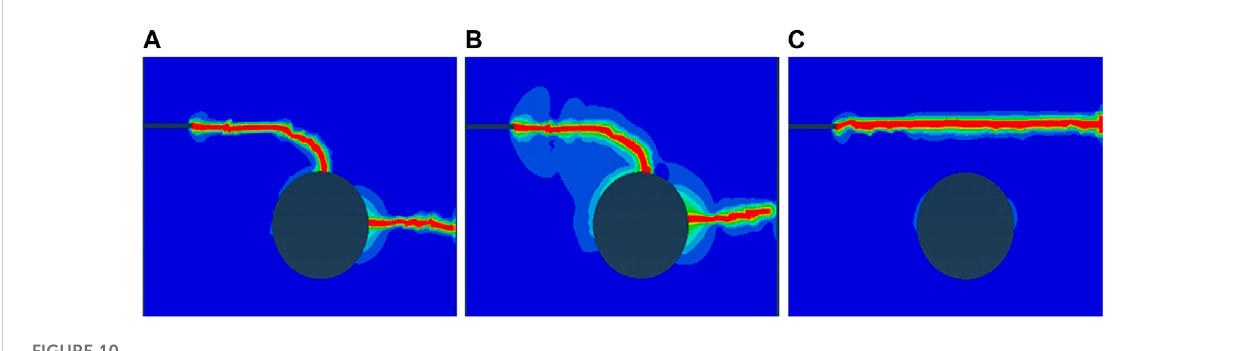
FIGURE 10 (A) CrackpropagationpathS=1.107(elementsize0.4). (B) CrackpropagationpathS=1.107(elementsize0.4). (C) CrackpropagationpathS=1.107 (element size